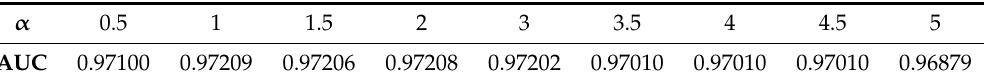
The Area Under roc Curve (AUC) value based on changing α and fixed pathway maximum length.